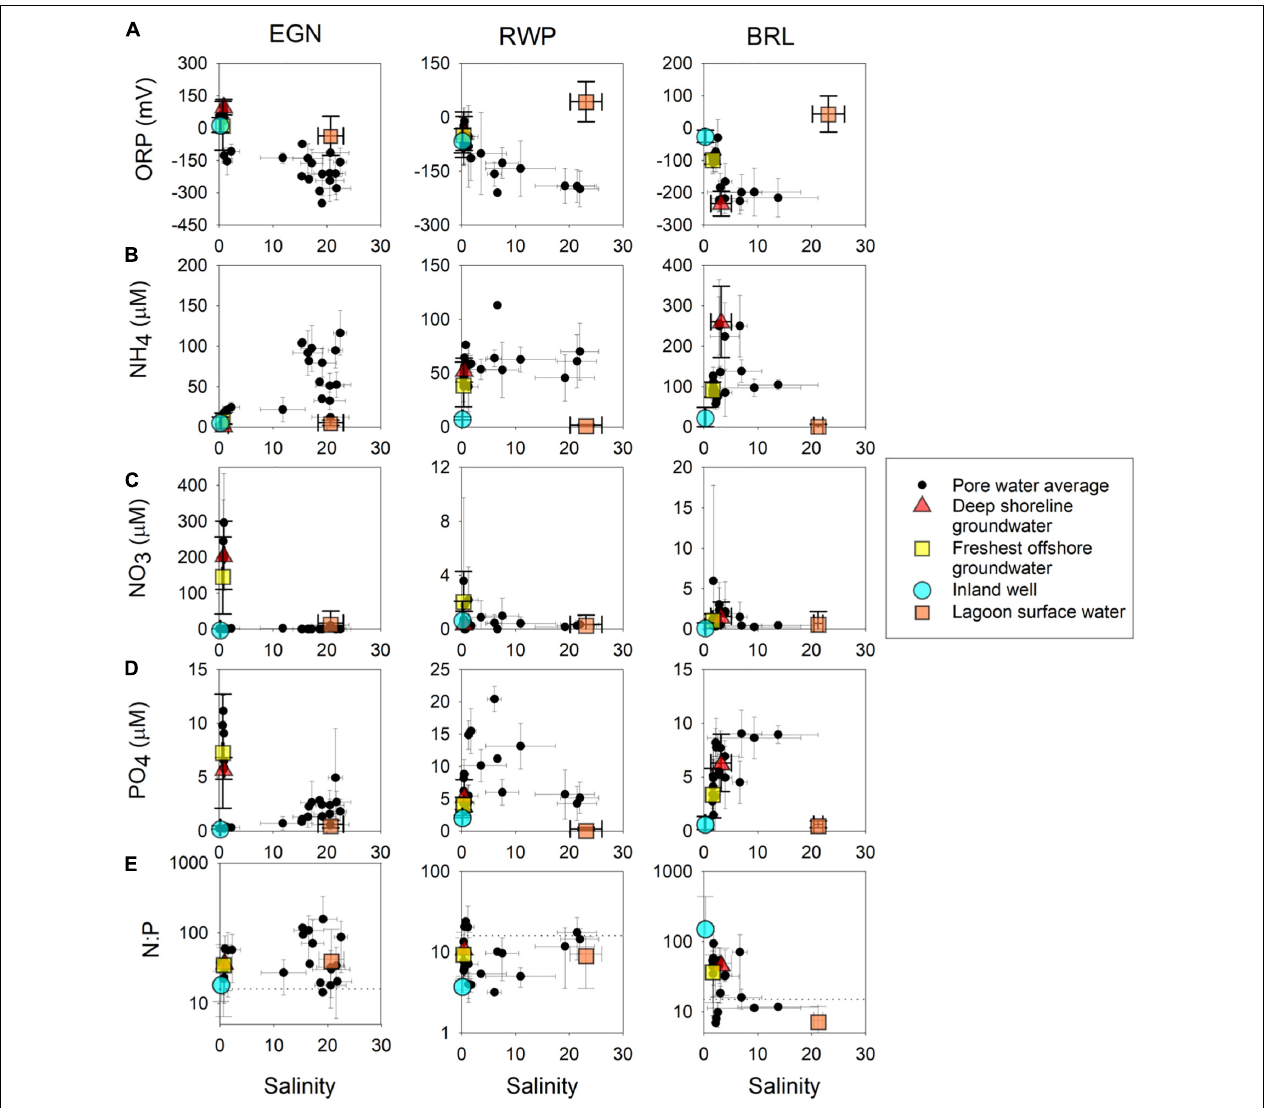
FIGURE 4 | Salinity versus (A) ORP, (B) NH 4 , (C) NO 3 , (D) PO 4 concentrations, and (E) molar N/P ratio of pore water, putative fresh-water end members, and saline lagoon water at all three sites. Fresh- and salt-water end members are shown with colored symbols and pore water concentrations are shown with black filled symbols. Values were calculated by averaging over the four sampling periods. Standard deviations of average values are shown with error